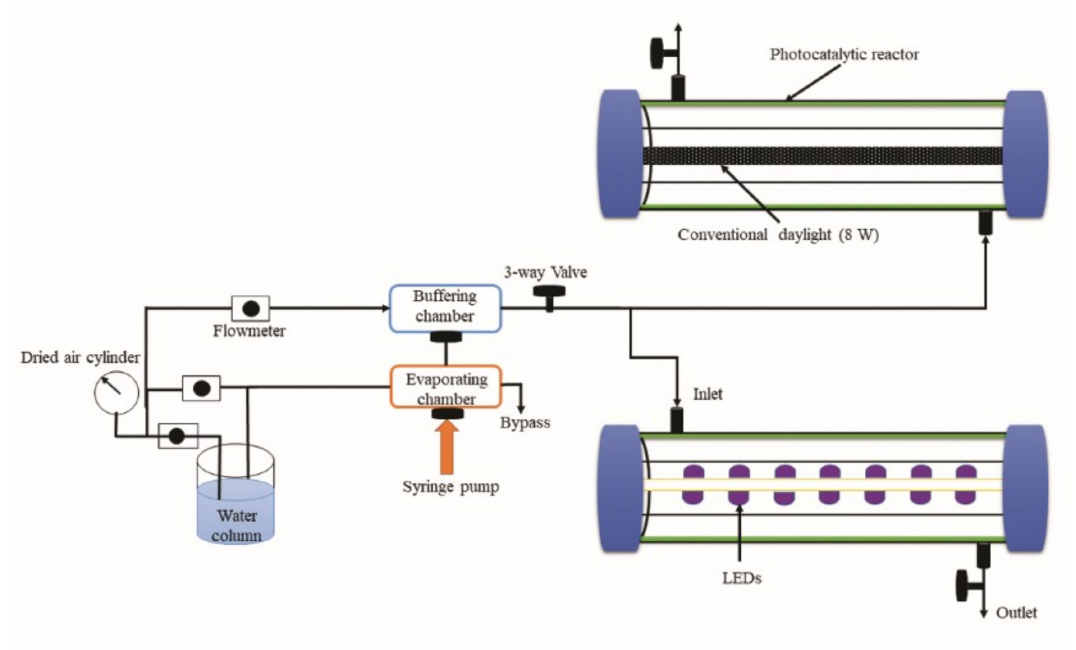
Figure 1. Schematic diagram of photocatalytic reactor